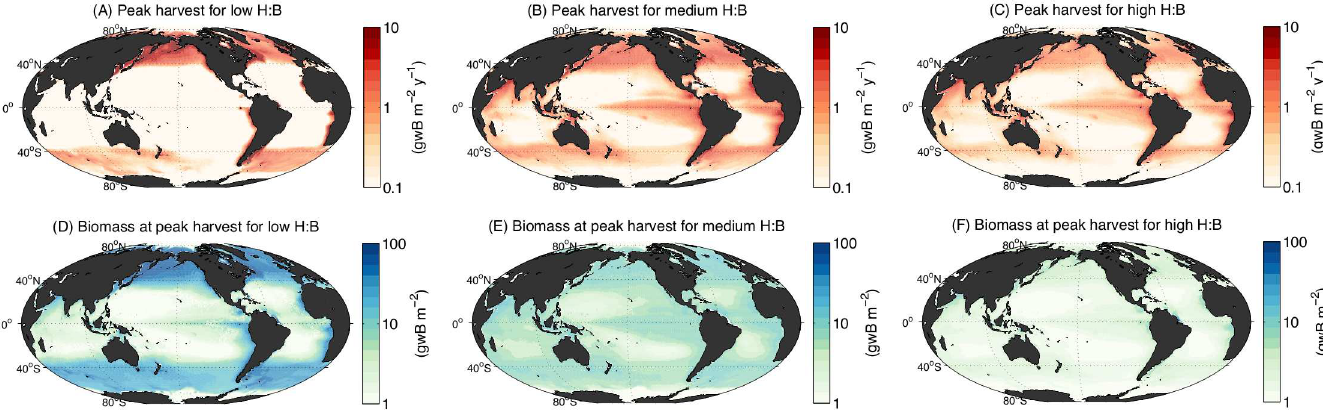
Fig 10. Two-dimensional global maps of harvestand biomass for three model variants with varying global harvestto biomass ratio (H:B). Maps show the annualaverageof the year of peak harvest. Harvest for low (A), medium (B), and high (C) H:B. Biomass for low (D), medium (E), and high (F)